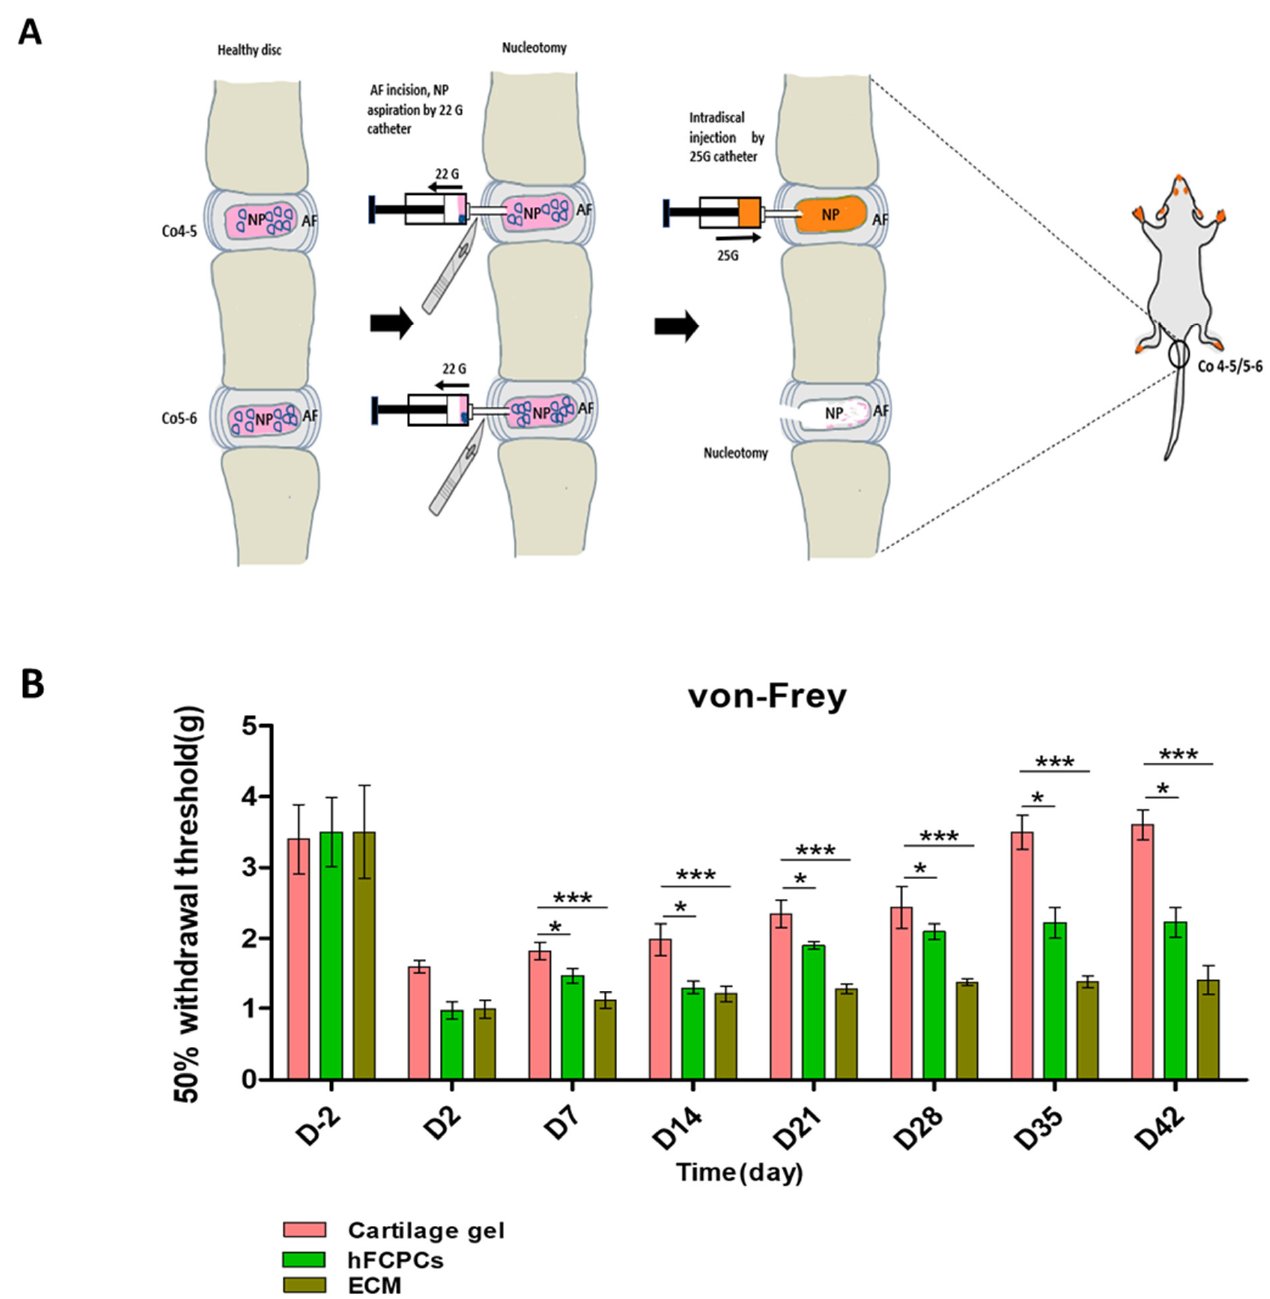
Figure 1. Schematic diagram of the surgical procedure and alleviation of the injury-induced pain phenotype by the cartilage gel. ( A ) Surgical procedures in a rat tail nucleotomy model; nucleus pulposus aspiration with a 22-gauge catheter through an annulus fibrosus incision. Injection of cartilage gel, hFCPCs, or ECM (15 µL using a 25-gauge catheter). ( B ) Alleviation of the injury-induced pain phenotype by the cartilage gel. In the von Frey test, the 50% withdrawal thresholds were significantly higher in the cartilage gel-treated group than in the hFCPCs or ECM-treated group. * p < 0.05; *** p < 0.001, significant difference between groups, by one-way ANOVA, n = 10 rats per group. hFCPCs, human fetal cartilage-derived progenitor cells; ECM, extracellular